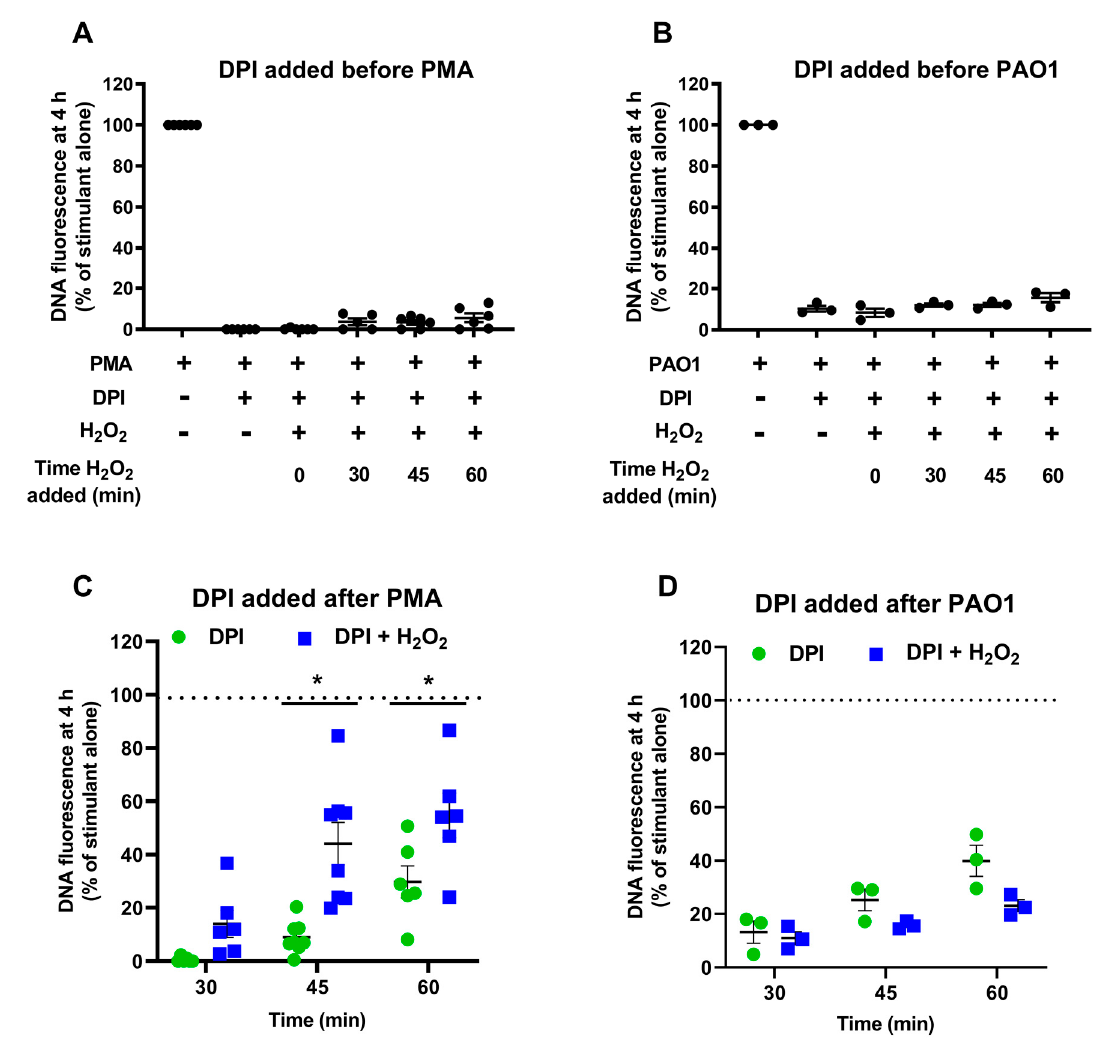
Figure 9. Effect of adding H 2 O 2 to DPI-treated stimulated neutrophils. Neutrophils were stimulated for 4 h with ( A , C ) PMA (20 nM) or ( B , D ) P. aeruginosa PAO1 (MOI 10). DPI was added before stimulation ( A , B ) or at the indicated times after stimulation ( C , D ). A 100 µM bolus of H 2 O 2 was added at the indicated times. Cells were then incubated for a total of 4 h and NET formation was assessed with Sytox green. Data are presented as the percentage of fluorescent DNA of cells with stimulant alone (No DPI). Data are the means (SE) of 3–6 separate experiments. *, significantly different to DPI alone at the same time point ( p < 0.001 by paired t -test).